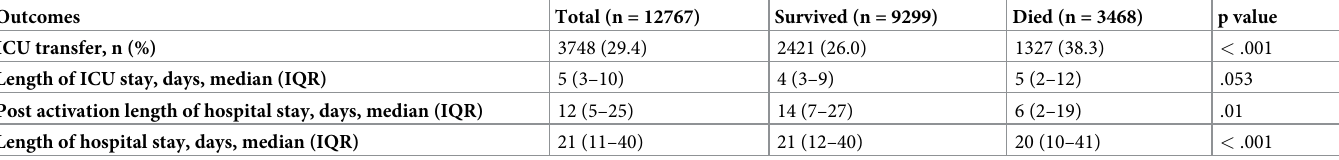
Table 5. Outcomes of the medical emergency team activation.